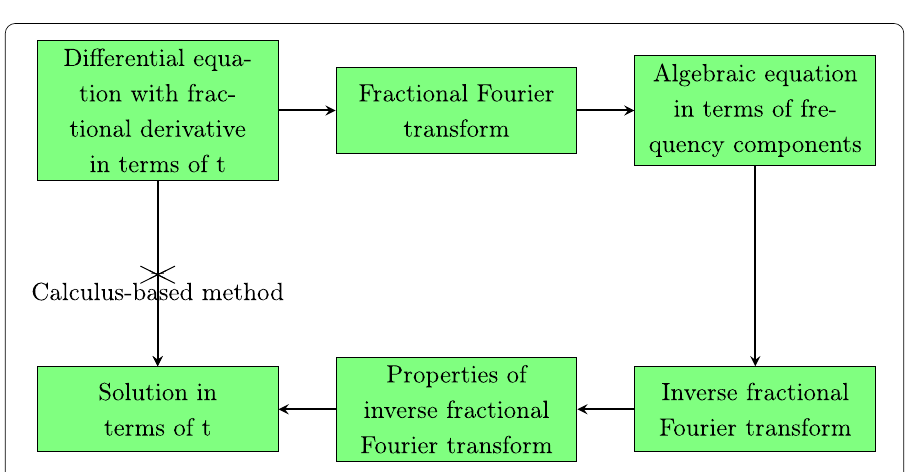
Figure 1 Flow chart of fractional Fourier transform for solving